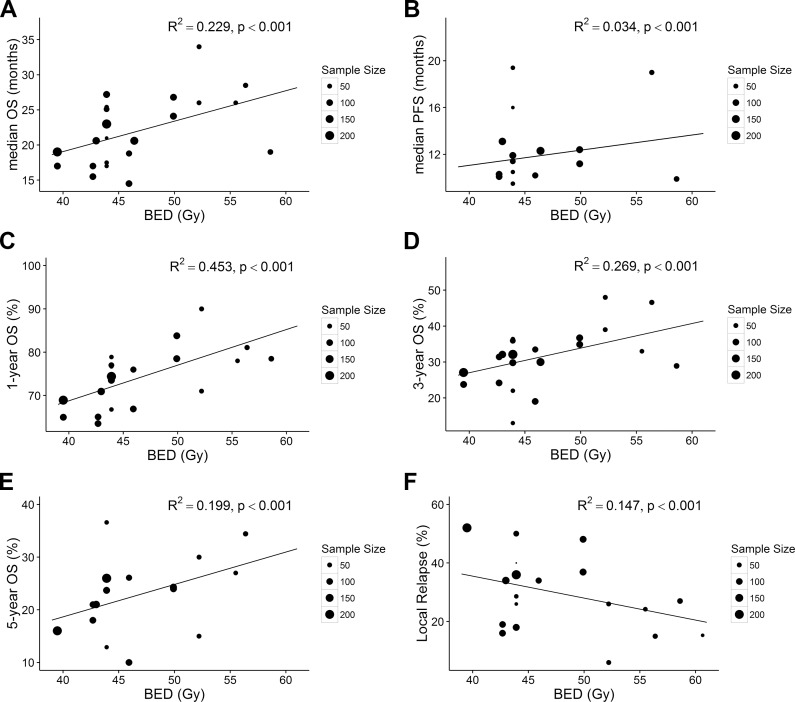
Association between BED and mOS (A), mPFS (B), 1-year OS (C), 3-year OS (D), 5-year OS (E), and LR (F) in the setting of concurrent chemo-radiotherapy. Each point in the plot represents a value of one arm. The point size represents the sample size. All analyses were conducted by linear regression methods weighted by sample size. BED, biological effective dose; mOS, median overall survival; 1-, 3-, 5-year OS, 1-, 3, 5-year overall survival; LR, local relapse